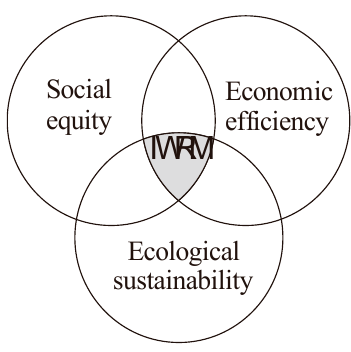
Figure 1. Integrated water resource management principle (adopted from Imjai et al. [29]).